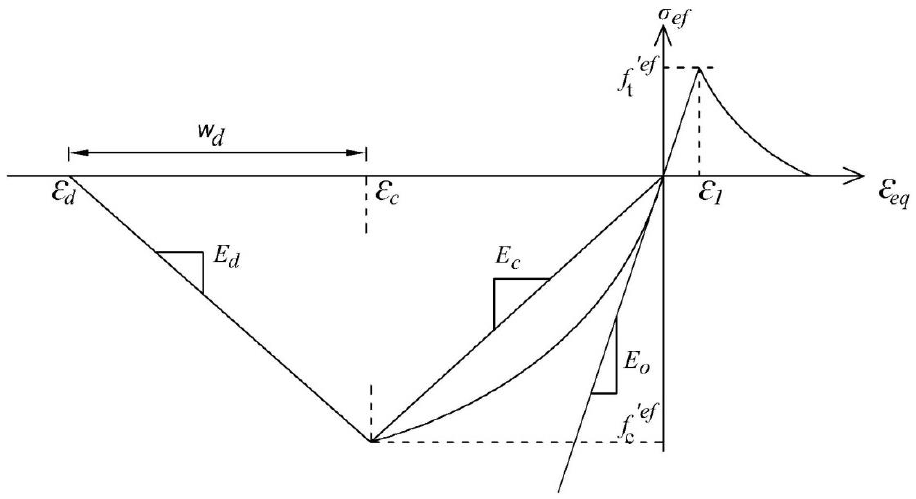
Figure 3. Uniaxial stress-strain law for concrete, reproduced with permission